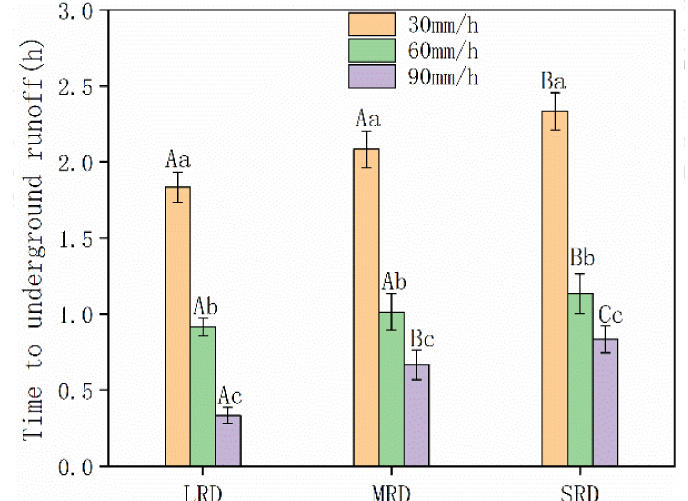
Figure 3. Time to underground runo ff under di ff erent rainfall intensities. Note: In the figure, the capital letter represented the significant di ff erence between di ff erent rainfall intensity under a certain degree of rocky desertification ( p < 0.05), and the lowercase letter represented the significant di ff erence between di ff erent degrees of rocky desertification under a certain degree of rainfall intensity ( p < 0.05). The initial time for the generation of underground runo ff of LRD was recorded to be the shortest, 51 min. For MRD and SRD, this time was 18.18% and 45.45% later than the one recorded for LRD. The time to reach the runo ff “flood” peak was 105 min, 75 min and 45 min, respectively, indicating that the time to reach the flood peak gradually shortened with the increase of the severity of rocky desertification. Furthermore, as shown in Figure 4, the maximum rate of underground runo ff was achieved with the highest rocky desertification. The maximum runo ff rate (8.24 L / h) of SRD was 1.20 times and 1.11 times higher than the ones recorded for the LRD and MRD scenarios, respectively.